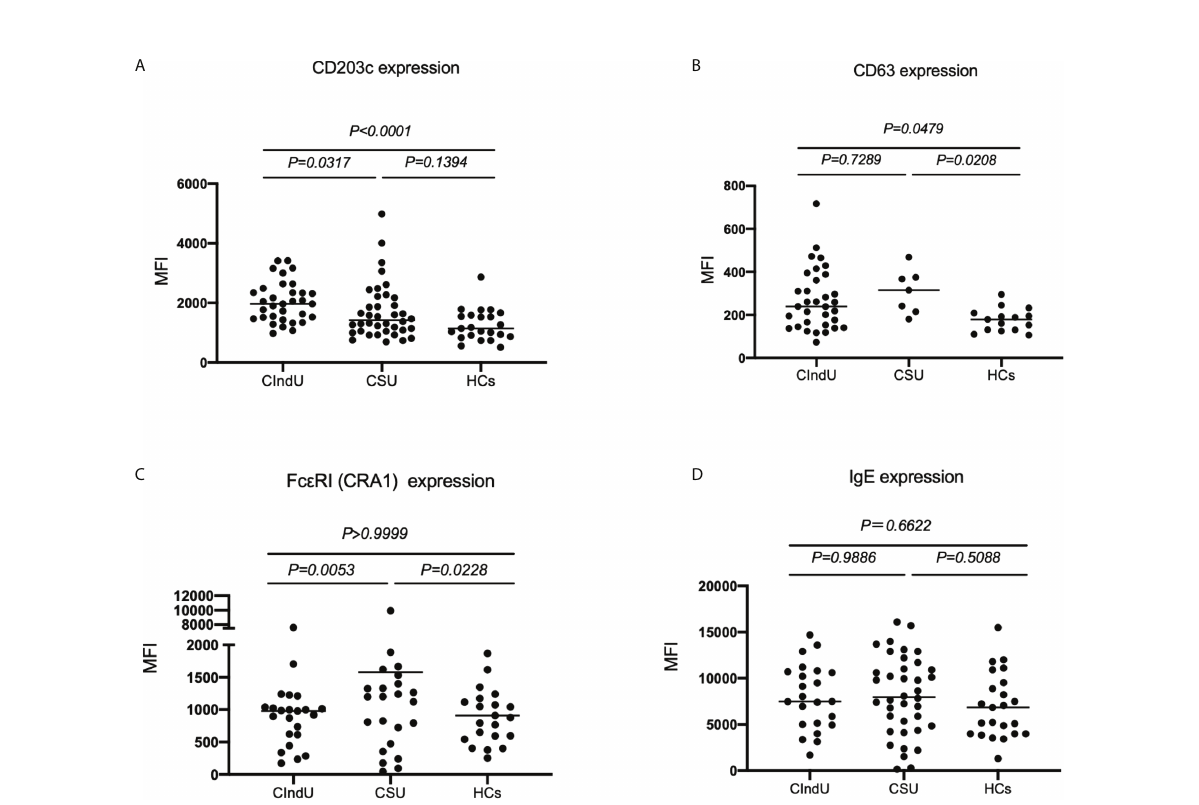
FIGURE 1 CD203c, CD63, IgE and Fc ϵ RI levels at steady state. (A) CD203c expression on basophils, (B) CD63 expression on basophils, (C) Fc ϵ RI expression on basophils and (D) IgE expression on basophils at steady state. Statistical analysis was carried out using the Kruskal-Wallis test with Dunn ’ s multiple comparisons